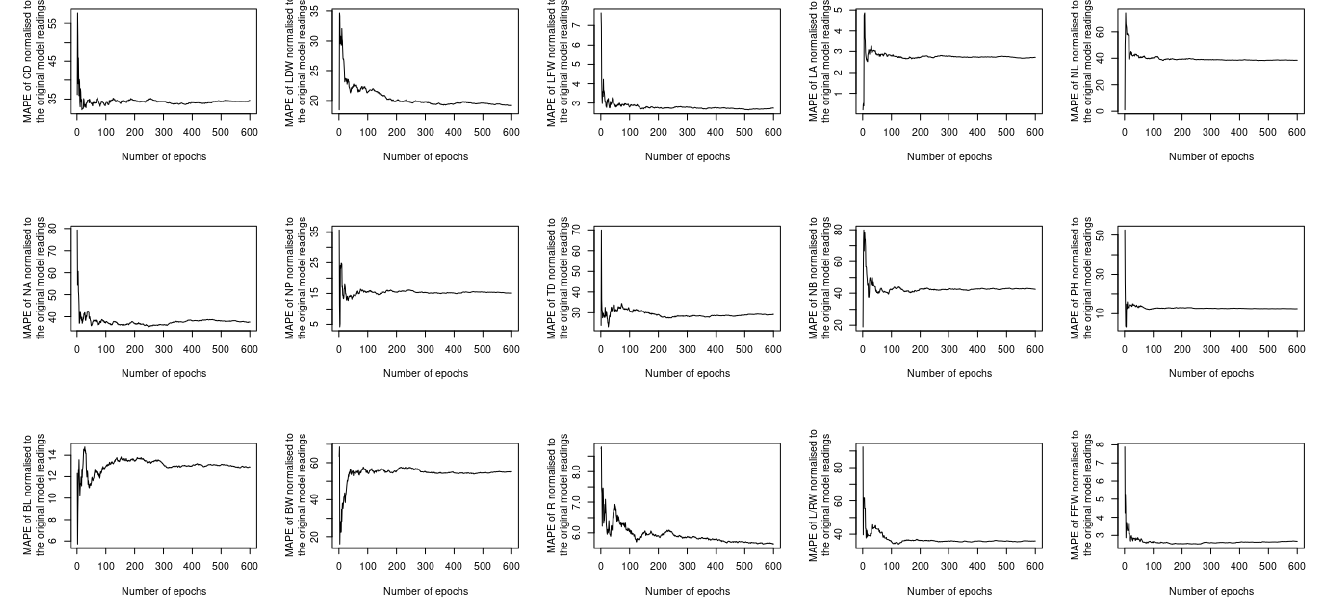
Figure 12. MAPE of the newly constructed models normalized to the original model .